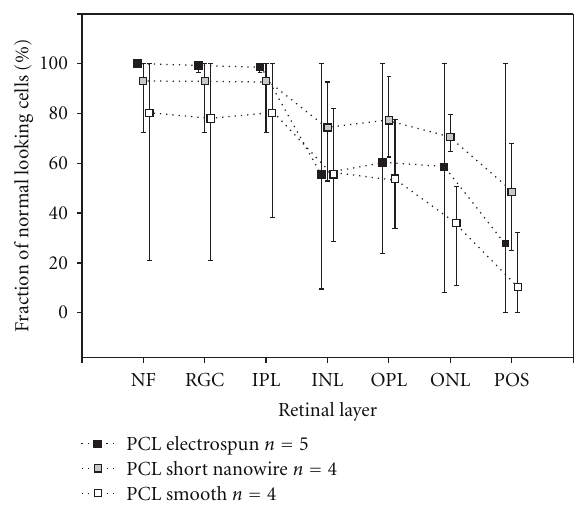
Figure 3: Mean fractions of morphologically intact membrane supported retinal layers for the three membrane types (squares). The lowest and highest scored fractions for each layer are given by the thin bars. Number of pigs included for histological scoring are given as n values in the figure.